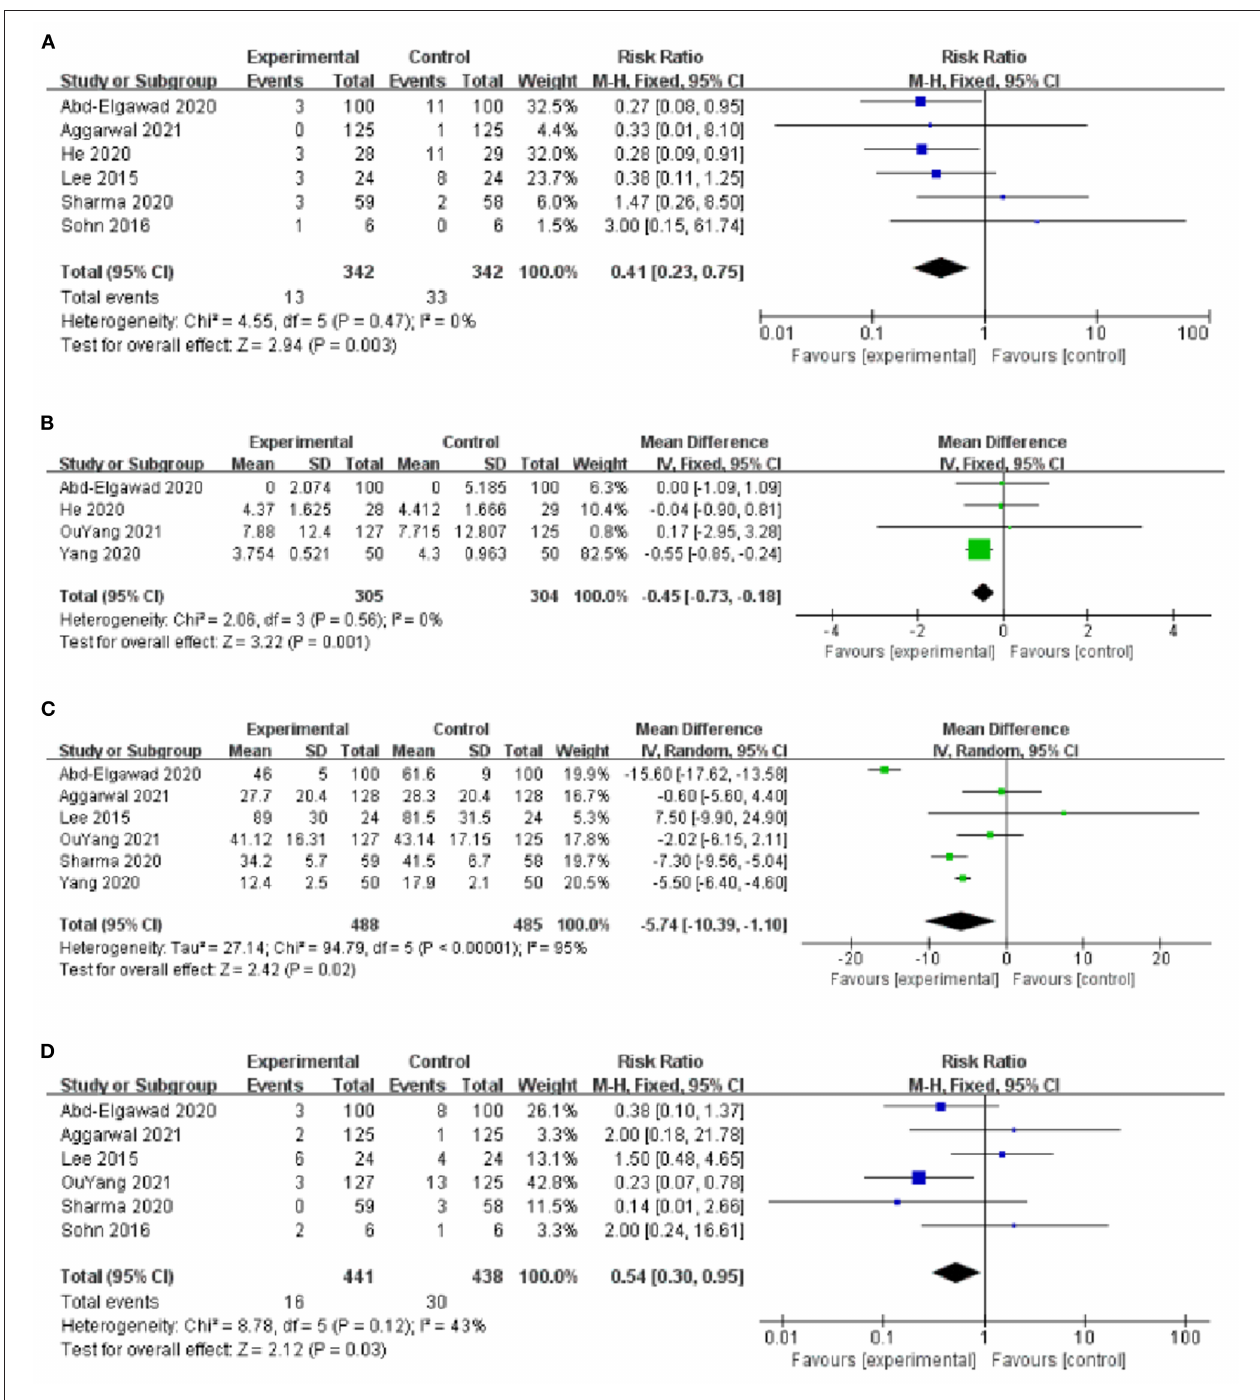
FIGURE 4 | (A) Forest plot of the incidence of VAP. (B) Forest plot of the MVT. (C) Forest plot of the LOS. (D) Forest plot of the incidence of NEC.